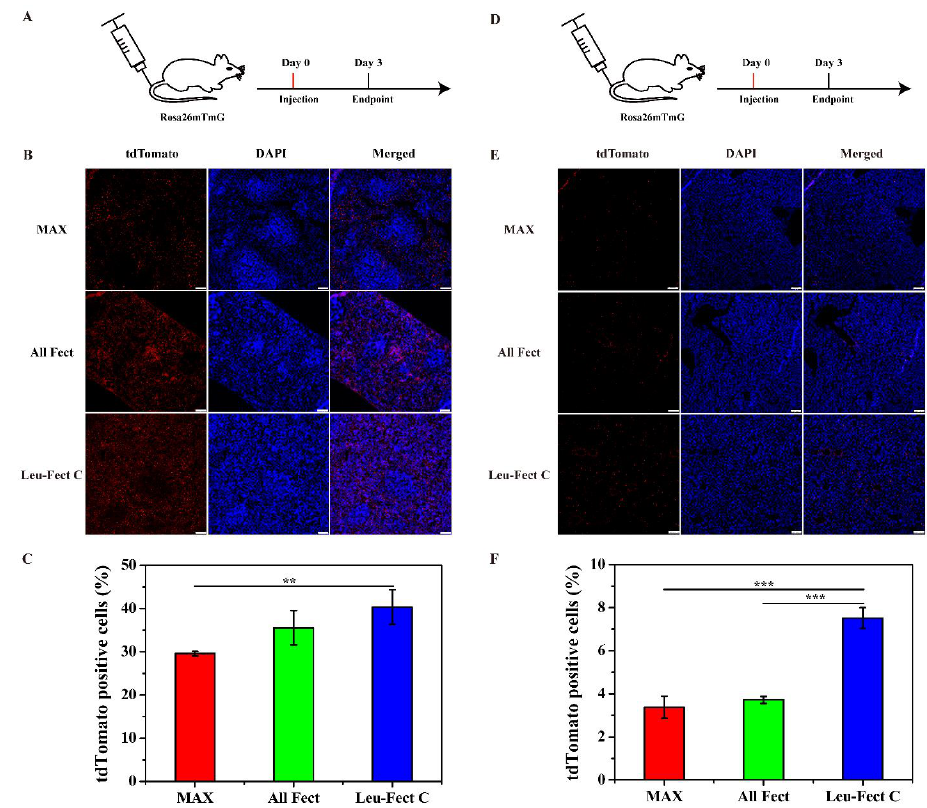
Figure 7. In vivo evaluation of modRNA delivery by tail vein injection. ( A , D ) Schematic depiction of in vivo transfection of Cre modRNA delivered by tail vein injection. ( B , E ) Three days after modRNA polymer complexes were injected into the tail vein; frozen sections of the spleen and liver were taken for staining to observe the effect of modRNA expression. Immunofluorescence picture of in vivo transfection efficiency of Cre-modRNA in the spleen and liver. Scale bar: 50 μm. ( C , F ) The statistical chart of tdTomato positive cells expression in spleen and liver. (Total n = 3 mice, ** p < 0.01, *** p <